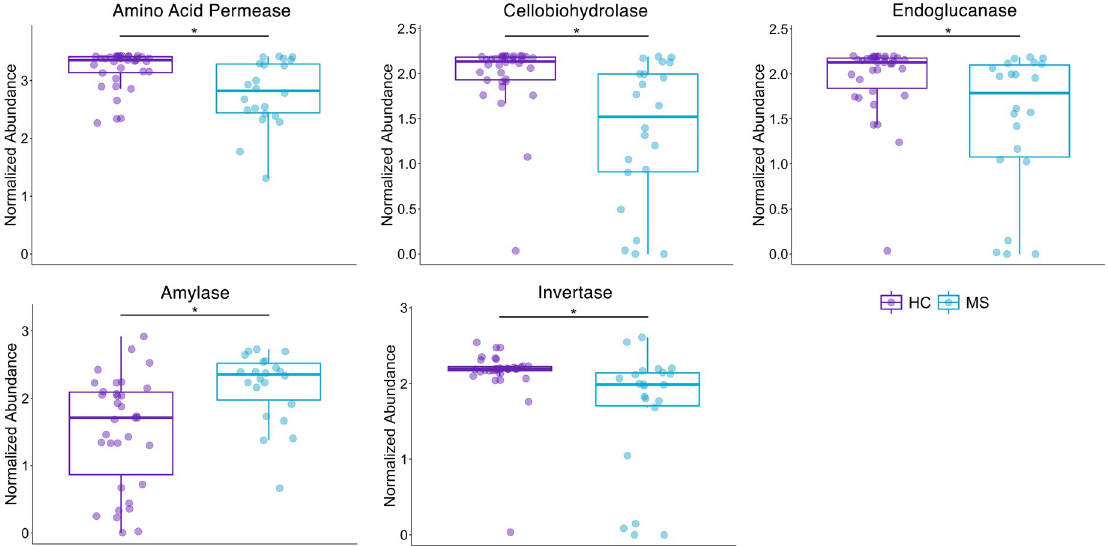
Fig 3. Functional profile of gut mycobiome in MS patients. Differentially enriched fungal functions using Wilcoxon signed rank test and adjusted for multiple comparisons with the Benjamini-Hochberg method at a significance level of 0.05. Amino acid permease, cellobiohydrolase, endoglucanase, and invertase are decreased in MS compared to HC. Amylase is increased in MS compared to HC. Abundance values are sum-scaled to 1 million and generalized log-transformed.